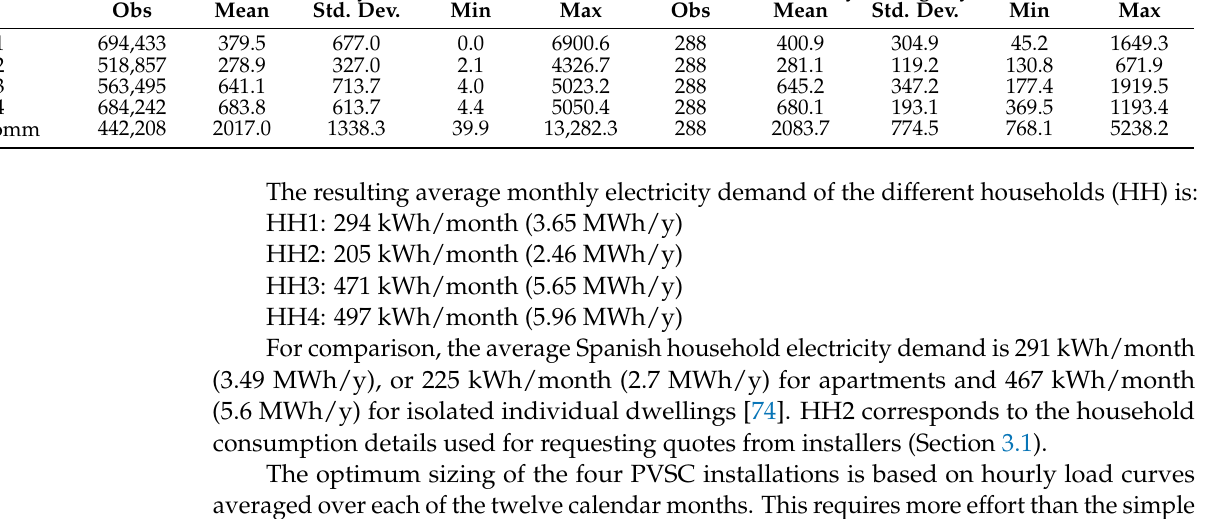
Table 2. Summary statistics of the power uptake (in Watts) of the individual households (HH1–HH4) and the solar community (Solar Comm), where all four households are grouped together. Minute by Minute Hourly Average by Month Obs Mean Std. Dev. Min Max Obs Mean Std. Dev. Min Max HH1 641.1 713.7 5023.2 288 645.2 347.2 177.4 1919.5 HH4